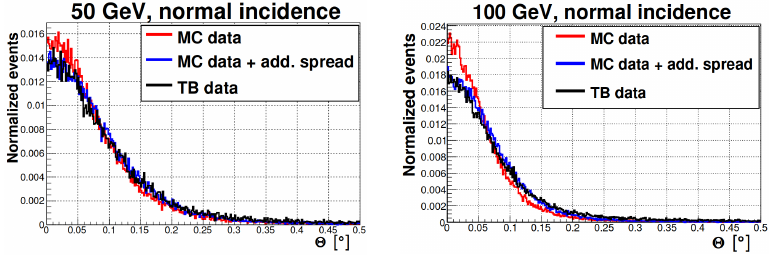
Figure 7. Angular resolution of the reconstructed tracks for 50 and 100 GeV electrons (from